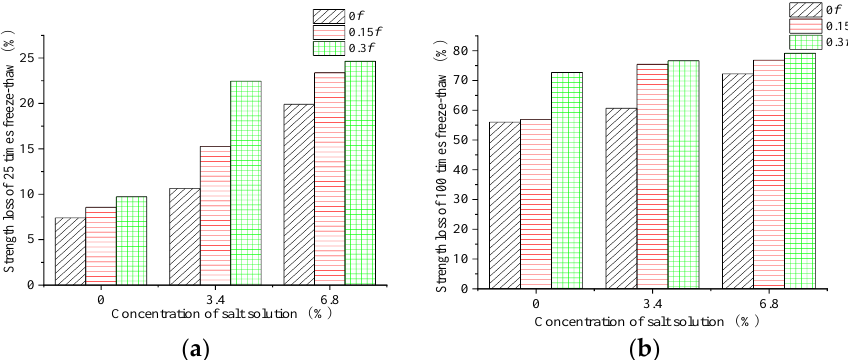
Figure 2. Change in the compressive strength with freshwater and two concentrations of salt solution. ( a ) After 25 freeze – thaw cycles. ( b ) After 100 freeze – thaw cycles.